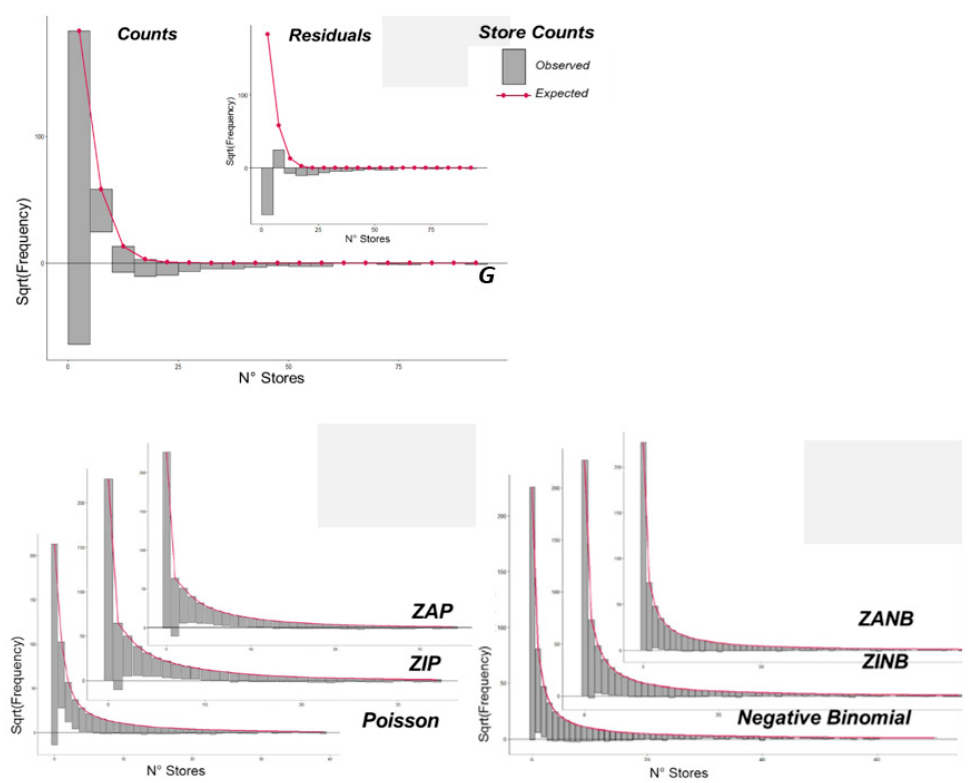
Figure 2. Rootgram of the global model (overall space study and variables) for: linear model G (top), Poisson regressions P-ZIP-ZAP (bottom-left) and negative binomial regressions NB-ZINB-ZANB (bottom-right). The last group of models showed a better fit between expected and observed values.